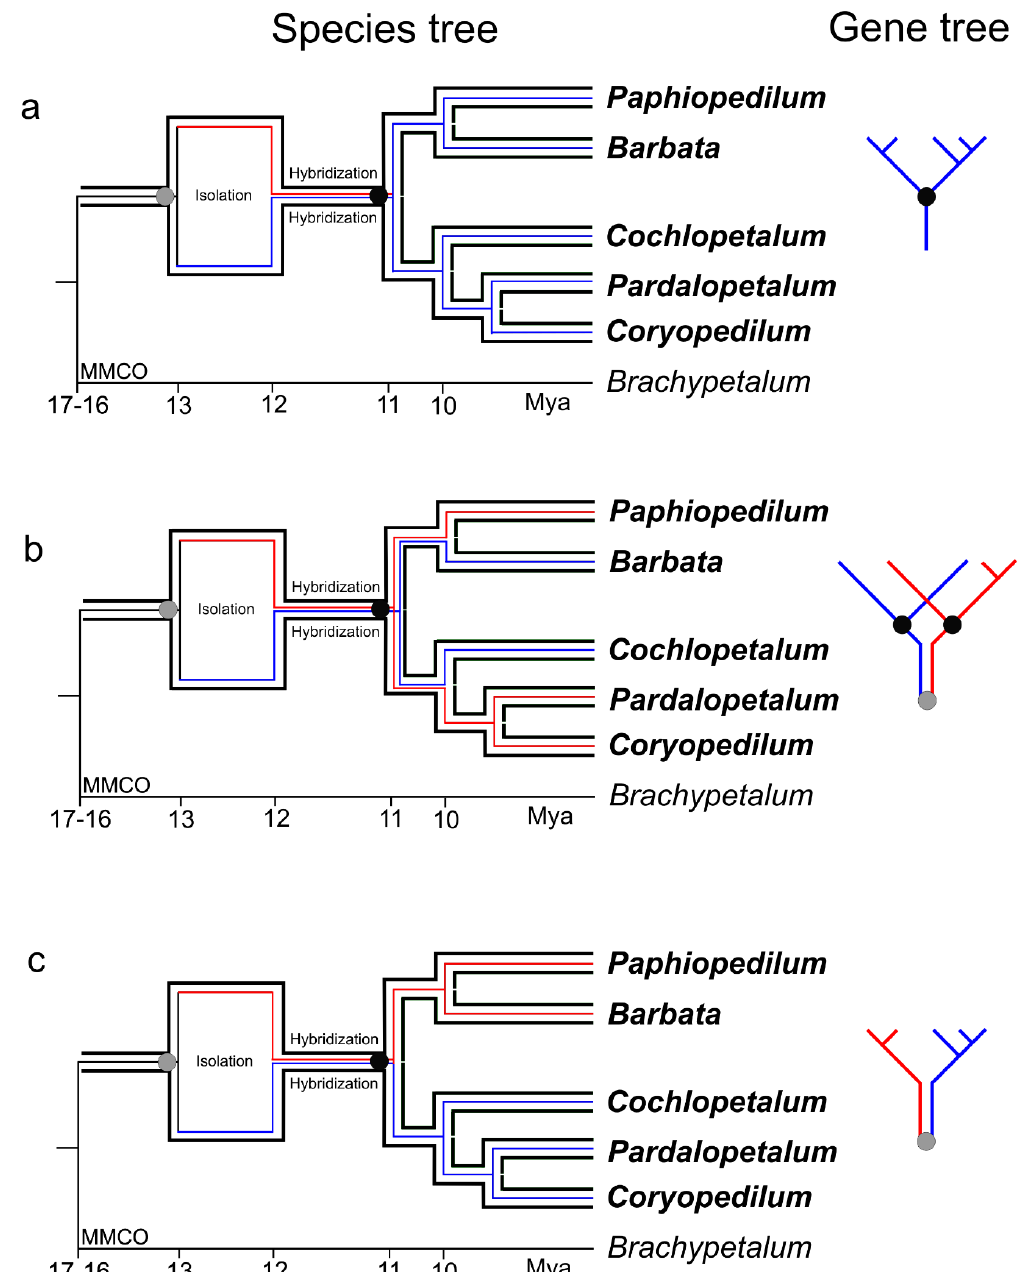
Figure 4. The species tree (black line) on which plastid gene tree ( a ), nuclear gene trees LFY ( b ), and PHYC ( c ) were applied. The illustration explains the reason for conflicts between gene trees and species trees within the subgenus Paphiopedilum . MMCO is the Mid-Miocene Climatic Optimum. Blue and red lines represent different gene copies (alleles/haplotypes) that diverged as a result of isolation/speciation. For the plastid gene tree, it was assumed that, after the hybridization process, only one haplotype remained ( a ). The nuclear gene tree for PHYC ( c ) and the plastid gene tree ( a ) have identical topology but different nodes with respect to their MRCA—a proto -Paphiopedilum subgenus (gray node) and Paphiopedilum subgenus (black node), respectively. The gene trees for LFY ( b ) and for PHYC ( c ) have different topologies but the same node with respect to their MRCA (gray node).